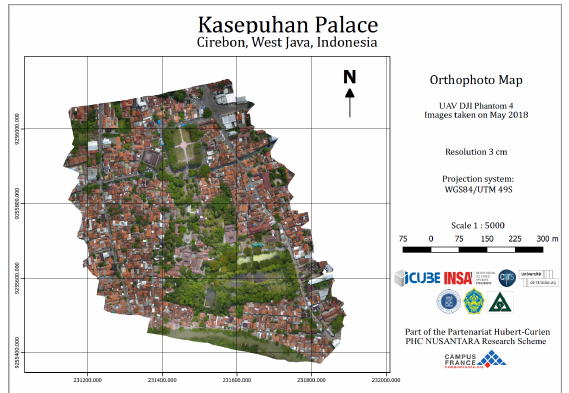
Figure 10. Orthophoto map of Kasepuhan and its surroundings, produced from aerial UAV images. This type of product is useful to assess the overall condition of the